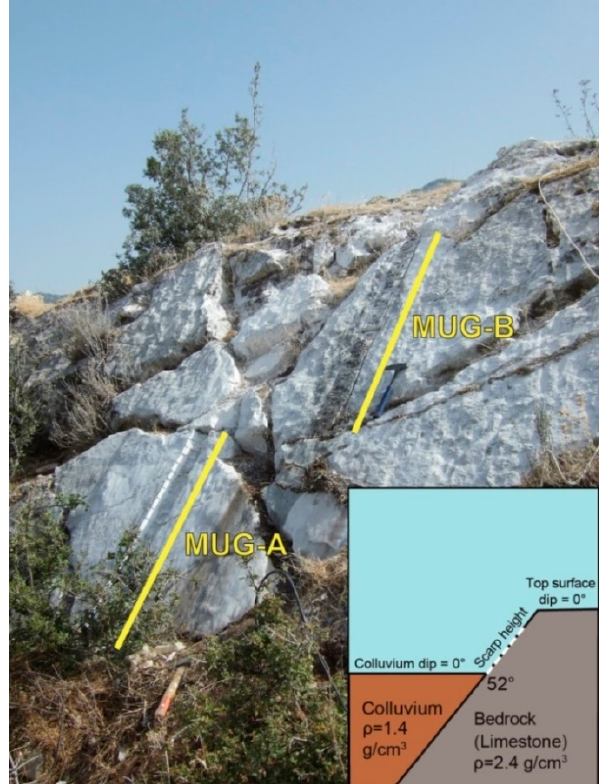
Figure 6. Mugırtepe fault scarp, view towards south with two sampling strips of MUG-A and MUG- B. The sampling has been done by [24]. Schematic sketch shows fault scarp with used parameters for modeling. White dashed line represents the sampled surface.